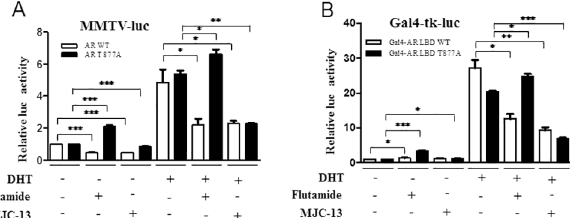
Fig 5. MJC13 inhibits a flutamide resistant AR mutant. Luciferase activity measured in HEK293T cells transfected with expression vectors for AR WT and AR T877A and an androgen-dependent MMTV-Luc reporter (A) or Gal4-AR LBD and Gal4-AR T877A and a GAL4 responsive reporter gene (B) and treated +/- DHT (1nM), +/- Flutamide (1 μ M), or +/- MJC13 (30 μ M) overnight, as in Fig 1. All data are representative of at least three independent experiments with similar results. All values represent the mean ± SD of duplicate samples. Transfections in Fig 5A employed 200ng of MMTV-luc, 100ng of AR or 100ng of AR T877A expression vectors and 100ng of β -gal whereas those in Fig 5B employed 300ng of Gal4-tk-luc, 200ng of Gal4-AR LBD or 200ng of Gal4-AR LBD T877A and 100ng of β